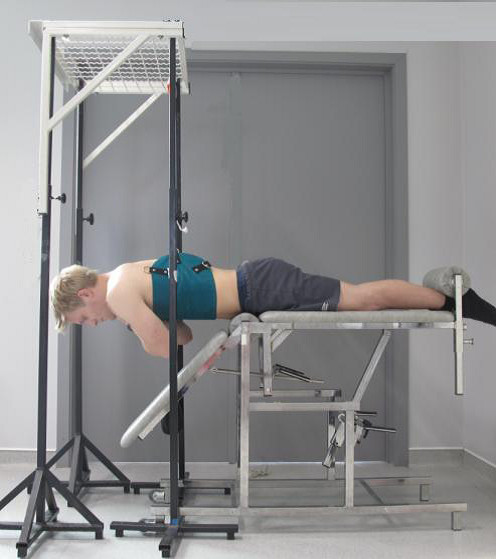
Position trunk extension exercises.